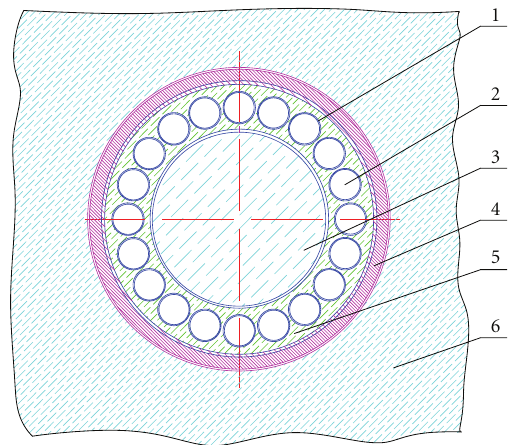
Figure 2: Thermal neutron fuel assembly. 1: zirconium shell, 2: thermal neutron fuel, 3: gaseous region, 4: fuel assembly case, 5: coolant, 6: moderator.